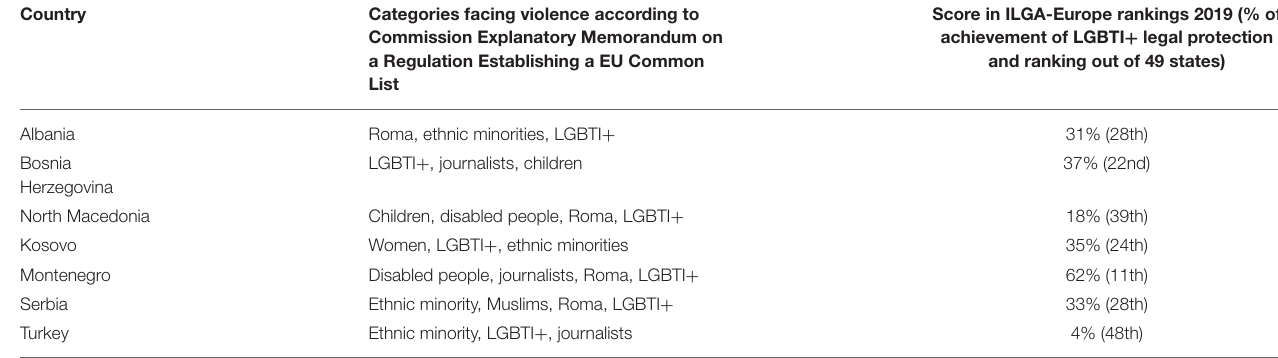
TABLE 2 | Groups facing violence in countries on the proposal for a common EU list. Country Categories facing violence according to Commission Explanatory Memorandum